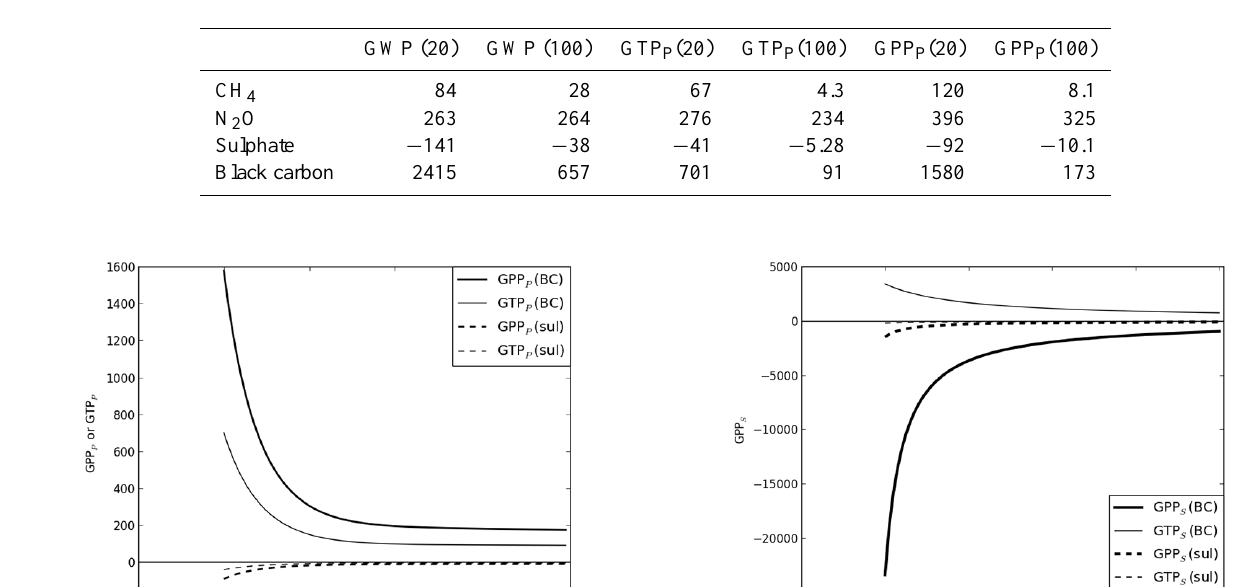
Table 2. The GWP, GTP P and GPP P , relative to CO 2 , for pulse emissions of four species at time horizons of 20 and 100 years, which are chosen for illustrative purposes. The absolute values of metrics for CO 2 are given in Table 1.